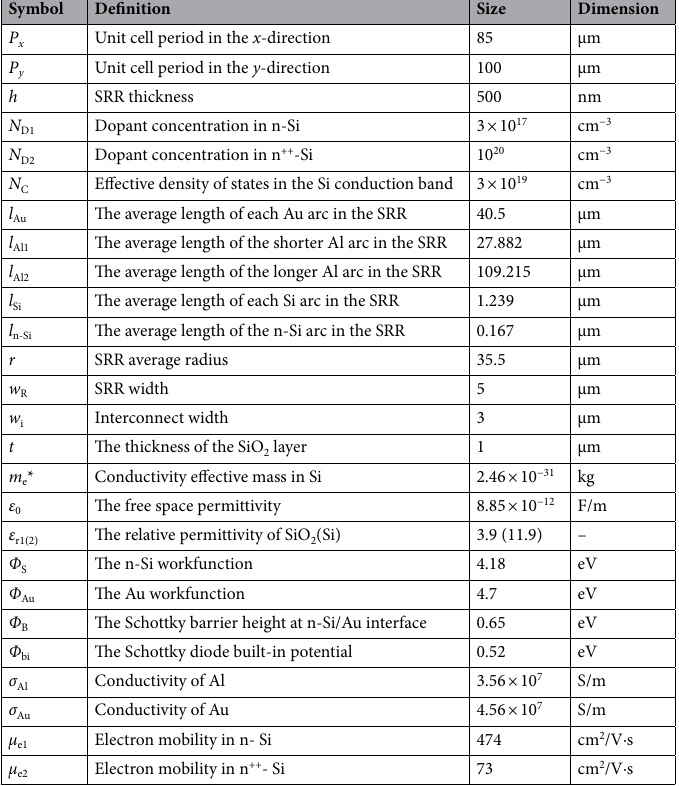
Table 1. Geometrical and physical parameters of the modulator unit cell and its constituents.